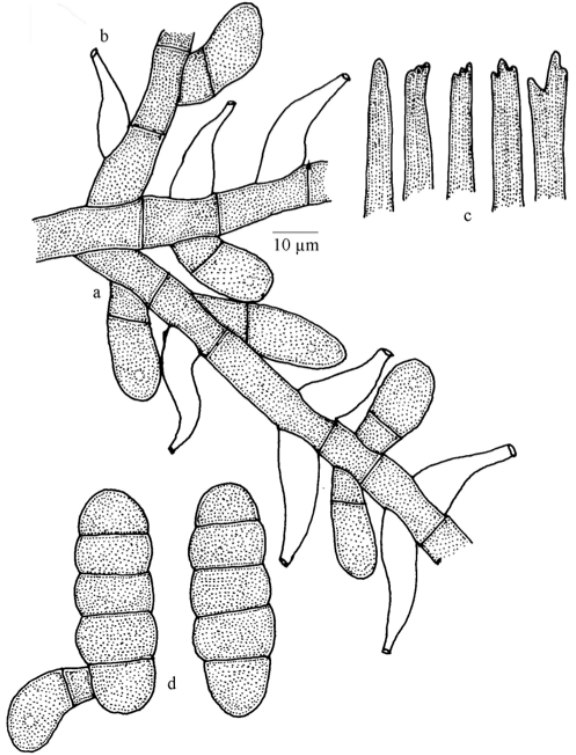
Figure 58. Meliola capensis var. allophylicola a - Appressorium; b - Phialide; c - Apical portion of mycelial setae; d - Ascospores